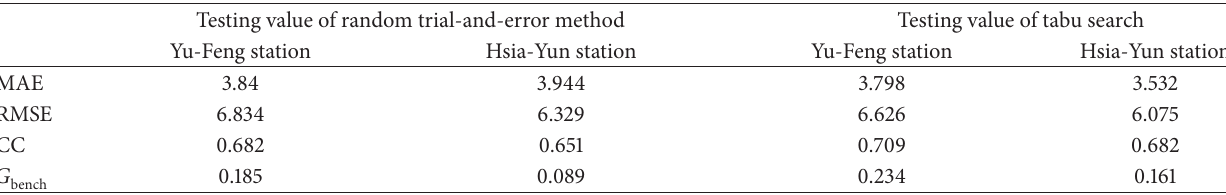
Table 4: Comparison of the value of assessment indices by applying tabu search and trial-and-error method for retrieving the optimal parameter and structure of ANFIS on testing stage. Testing value of random trial-and-error